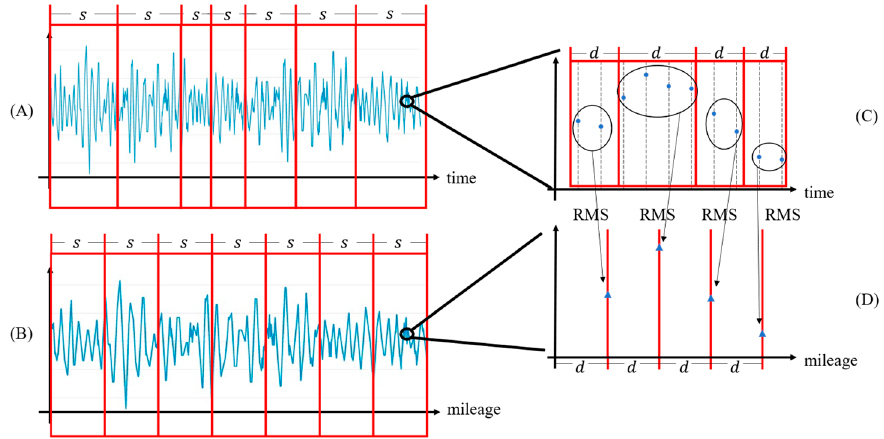
Figure 5. ( A ) ETI data; ( B ) transformed EDI data; ( C ) zoom-in ETI data; ( D ) zoom-in transformed EDI data. (the RMS means root mean square)